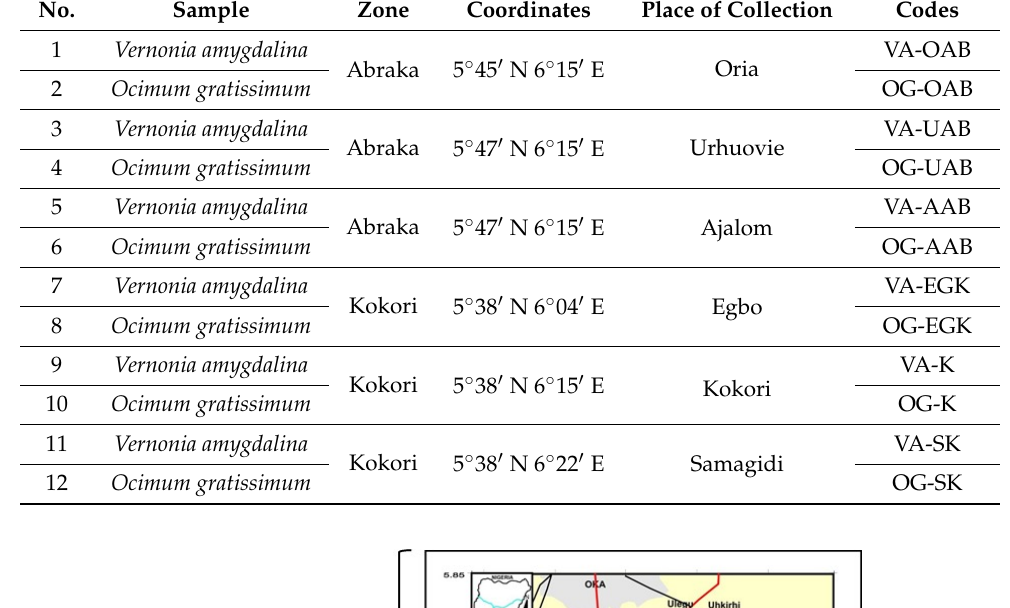
Table 1. Zone, coordinates, and collection sites.